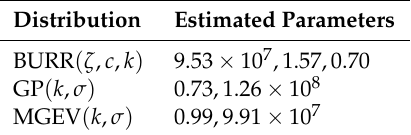
Table 3. Estimated parameters for three severity distributions (Burnecki and Giuricich